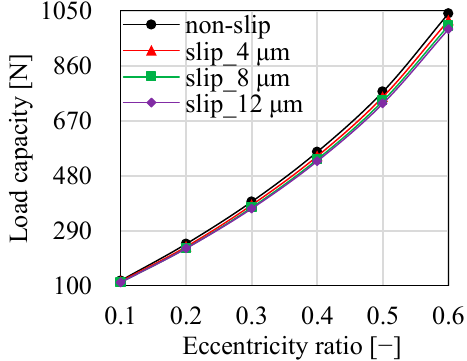
Figure 9. Load capacity under different slip lengths.